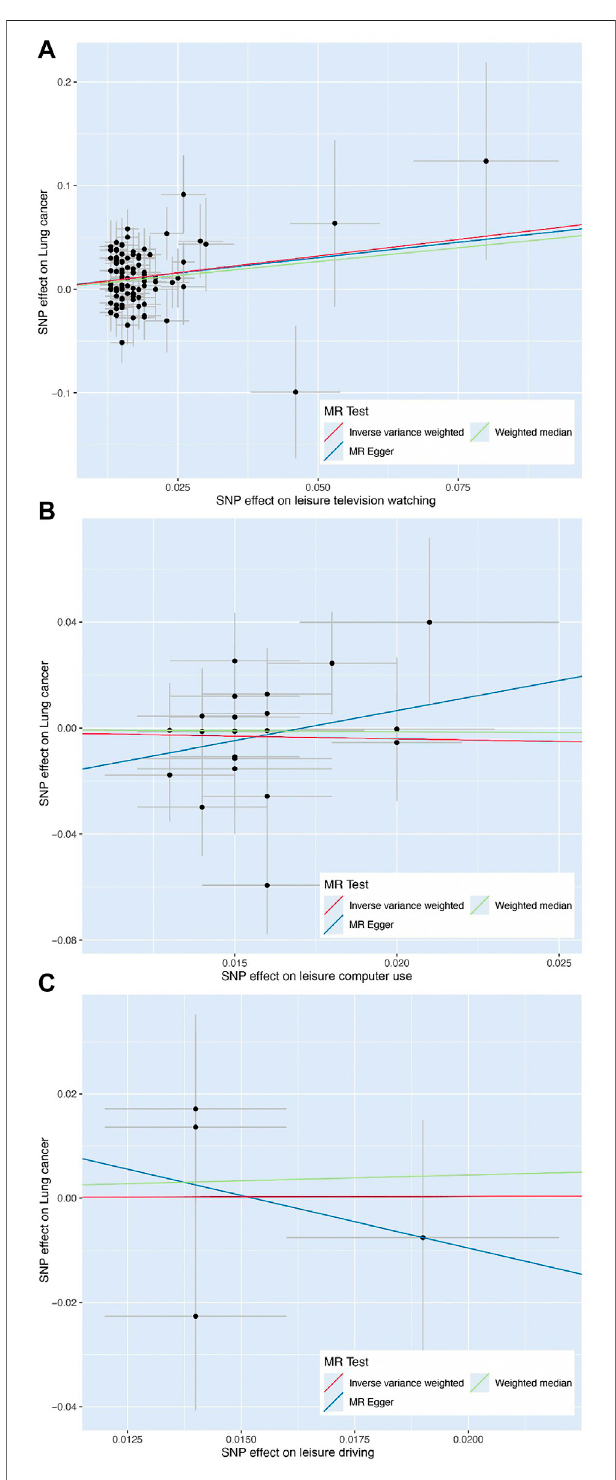
FIGURE 3 | Scatter plot of the effect size of each single-nucleotide polymorphism on leisure television watching (A) , leisure computer use (B) , and leisure driving (C) and lung cancer risk using Mendelian randomization approaches, including inverse variance-weighted, weighted median, and MR-Egger,